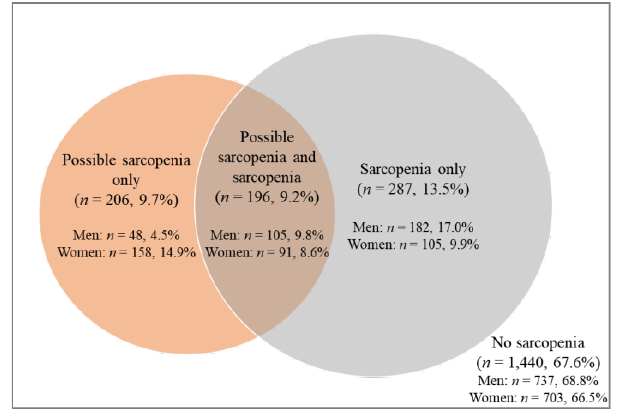
Figure 2. Venn diagram depicting the overlaps between possible sarcopenia and sarcopenia. The number of participants with both possible sarcopenia and sarcopenia was 196 (9.2%); 105 (9.8%) were men and 91 (8.6%) were women.